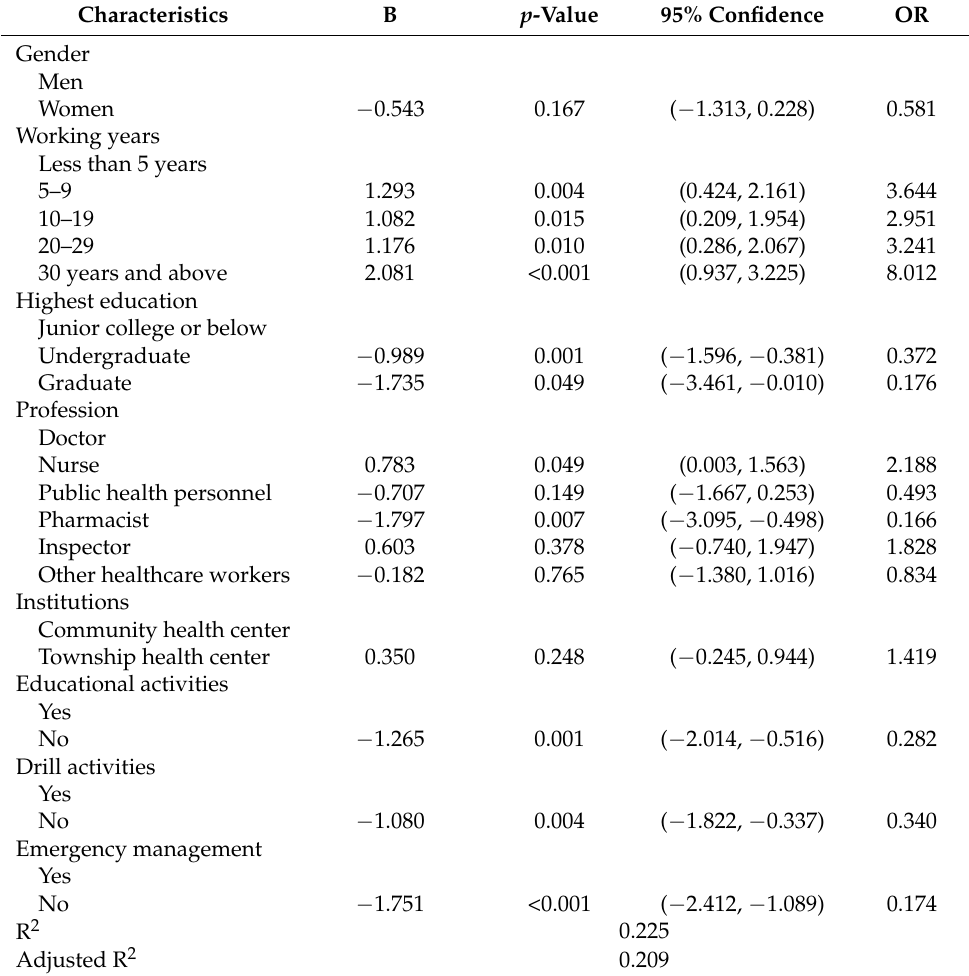
Table 6. Practical ability of healthcare workers toward PHEs and associated factors (linear regression model).